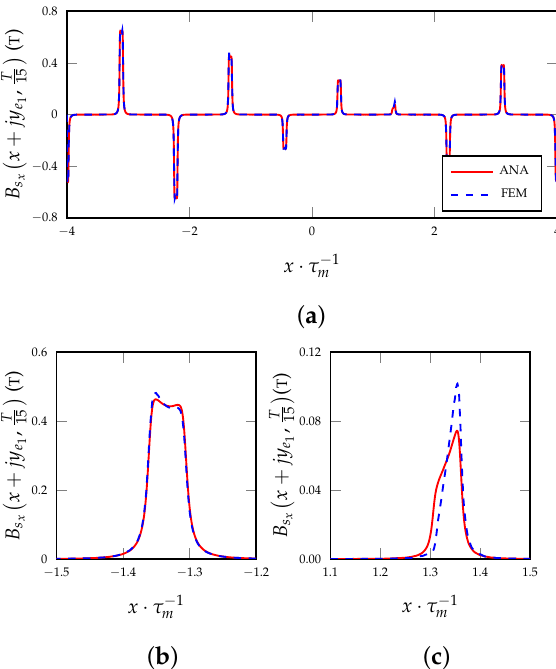
Figure 14. Analytical (slotted current sheets model) and FEM (slotted machine of Figure 4a) armature reaction flux density tangential component on the exploration line at y e